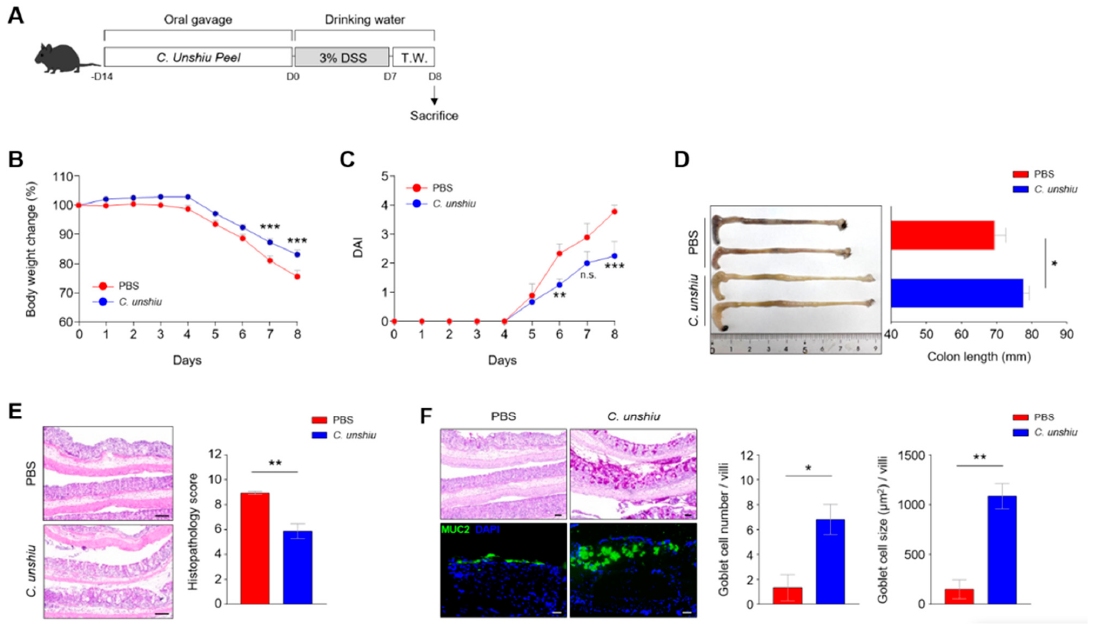
Figure 3. Citrus unshiu peel (CUP) ameliorates dextran sulfate sodium (DSS)-induced inflammation in vivo. ( A ) Scheme of the treatment with CUP and 3% DSS water in murine model. Body weight change ( B ) and fecal pathogenicity was monitored, and the disease activity index (DAI) ( C ) was evaluated for eight days during the induction of colitis. Representative image of the colon length ( D ) ( left ) and its quantification bar graph ( D ) ( right ) with phosphate-buffered saline (PBS) and CUP- treated mice. The large intestine of the PBS- and CUP-treated mice were analyzed via hematoxylin and eosin (H&E) staining ( E ), periodic acid-Schiff (PAS) staining, and immunofluorescence (IF) staining for mucin 2 (MUC2) ( F ) and shown as representative images and quantification bar graphs. All data are represented as the mean ± standard error of the mean (SEM) of independent individuals. Statistical analyses were conducted using two-way analysis of variance (ANOVA) with Sidak’s multiple comparisons test for body weight change and DAI and the unpaired t -test for colon length and histology score. * p < 0.05, ** p < 0.01, and *** p < 0.001; n.s., not significant. Scale bar = 100 µ m.